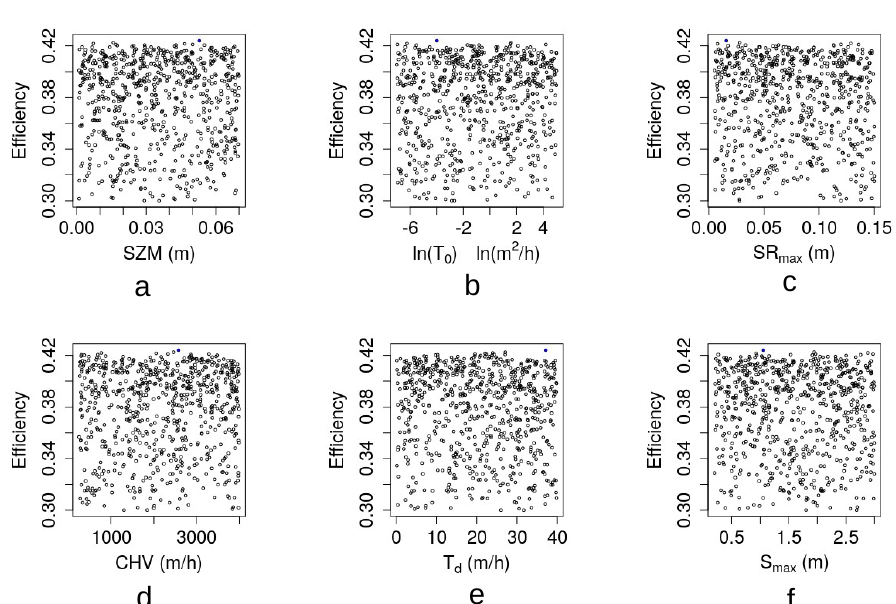
Figure 5. Scatter plot of efficiency versus behavioral parameters values ( a ) Form of exponential decline in conductivity, ( b ) Effective lateral saturated transmissivity, ( c ) Maximum root zone storage, ( d ) Channel routing velocity, ( e ) Unsaturated zone time delay, ( f ) Maximum effective deficit of subsurface saturated zone, for 32 years’